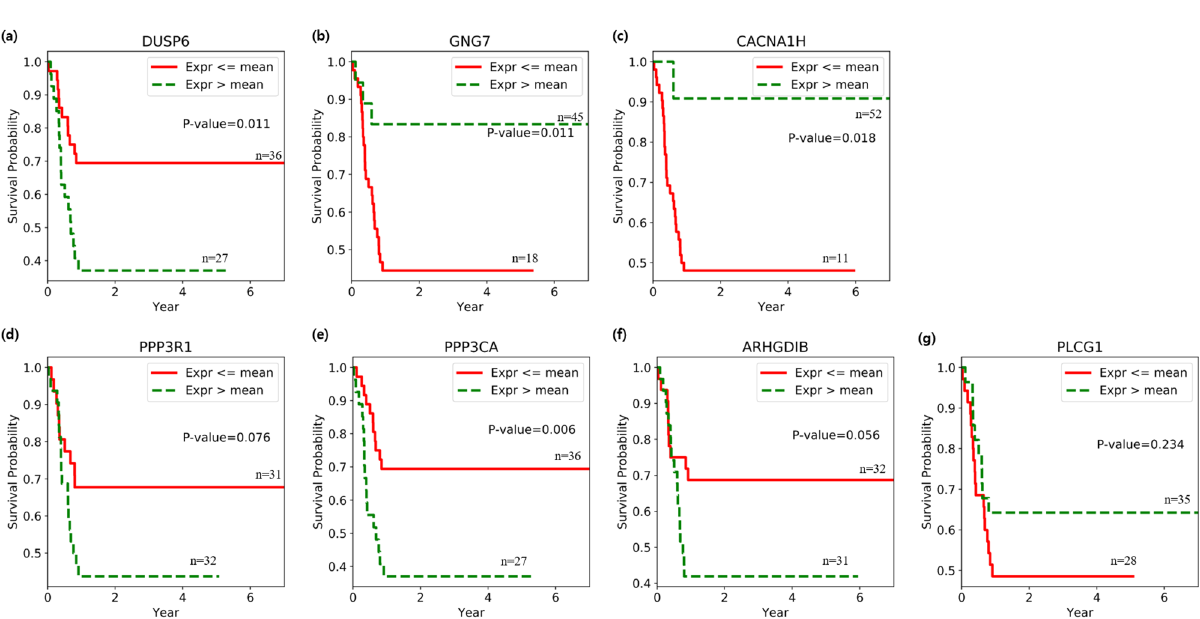
Figure 6. Kaplan–Meier curves. Red line refers to survival probability of patients providing samples for which gene expression values are greater than or equal to average, and green line means survival probability of samples with expression values less than average. (a) DUSP6 , (b) GNG7 , (c) CACNA1H , (d) PPP3R1 , (e) PPP3CA , (f) ARHGDIB , (g) PLCG1